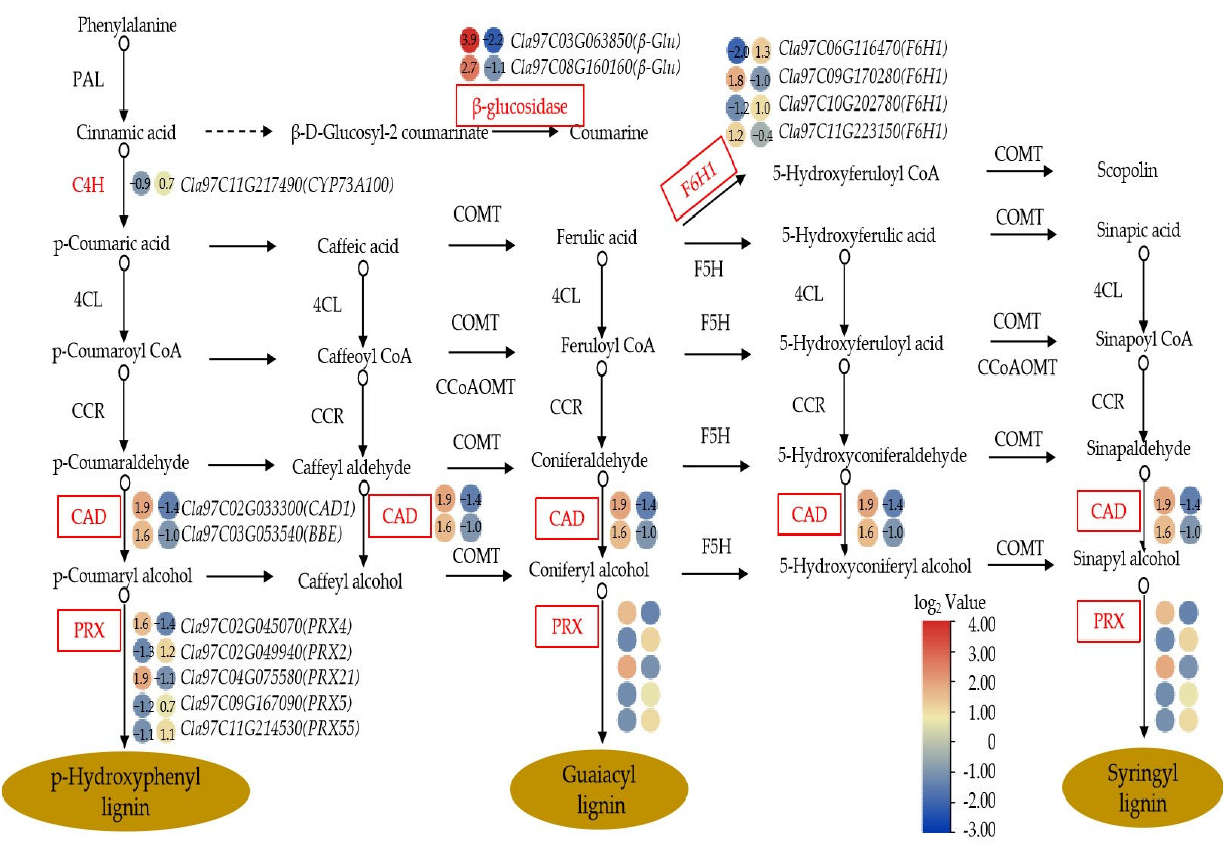
Figure 7. Analysis of phenylpropanoid biosynthesis in terms of DEGs. The dots on the left represent the CK2–CK1 comparison group, and those on the right represent the T–CK2 comparison group. The color scale ranges from − 3 to 4, with blue indicating down ‐ regulation and red indicating up ‐ regulation (see the color set scale). CK1 represents watermelon seedlings cultured in normal Hoagland solution; CK2 represents watermelon seedlings cultured in Hoagland solution containing 150 mM NaCl, and T represents watermelon seedlings cultured in Hoagland solution containing 150 mM NaCl and 20 mM trehalose.